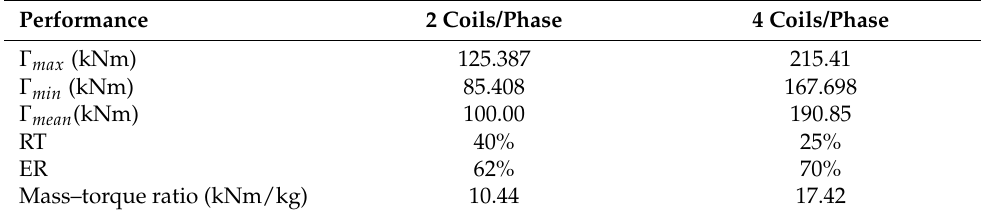
Table 5. Otpimal torque, torque ripple and energy ratio